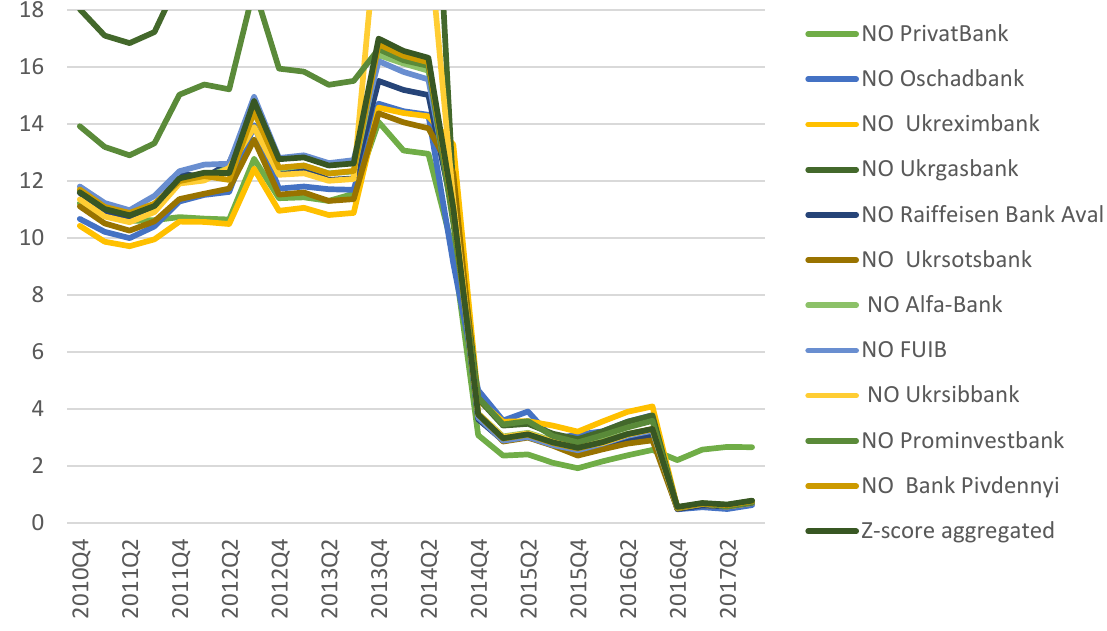
Figure 3. Trends in aggregated Z-scores and minus one bank Z-scores for Ukrainian banks, calculated using Approach